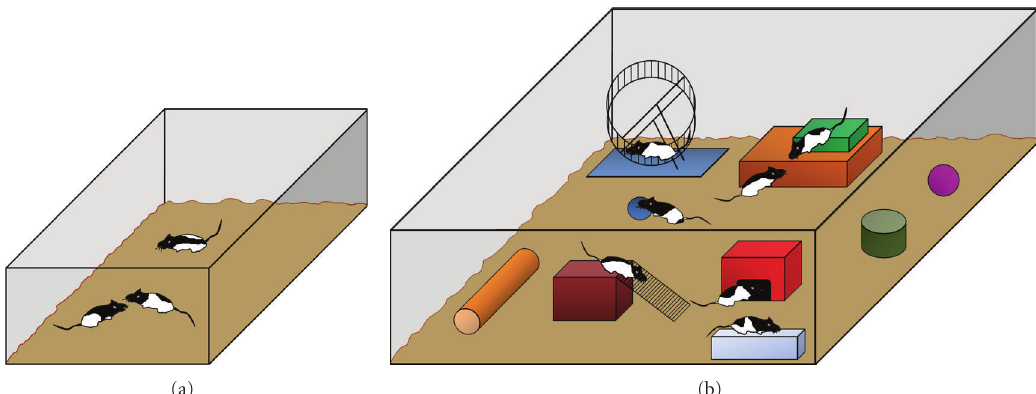
Figure 1: (a) Standard laboratory cage for animal rearing; (b) enriched environment (EE) , defined as the combination of complex inanimate and social stimulation, formed by bigger cage than standard ones, full of toys of di ff erent colors, shapes, tunnels, material to construct the nest, a shelter, and an exercise